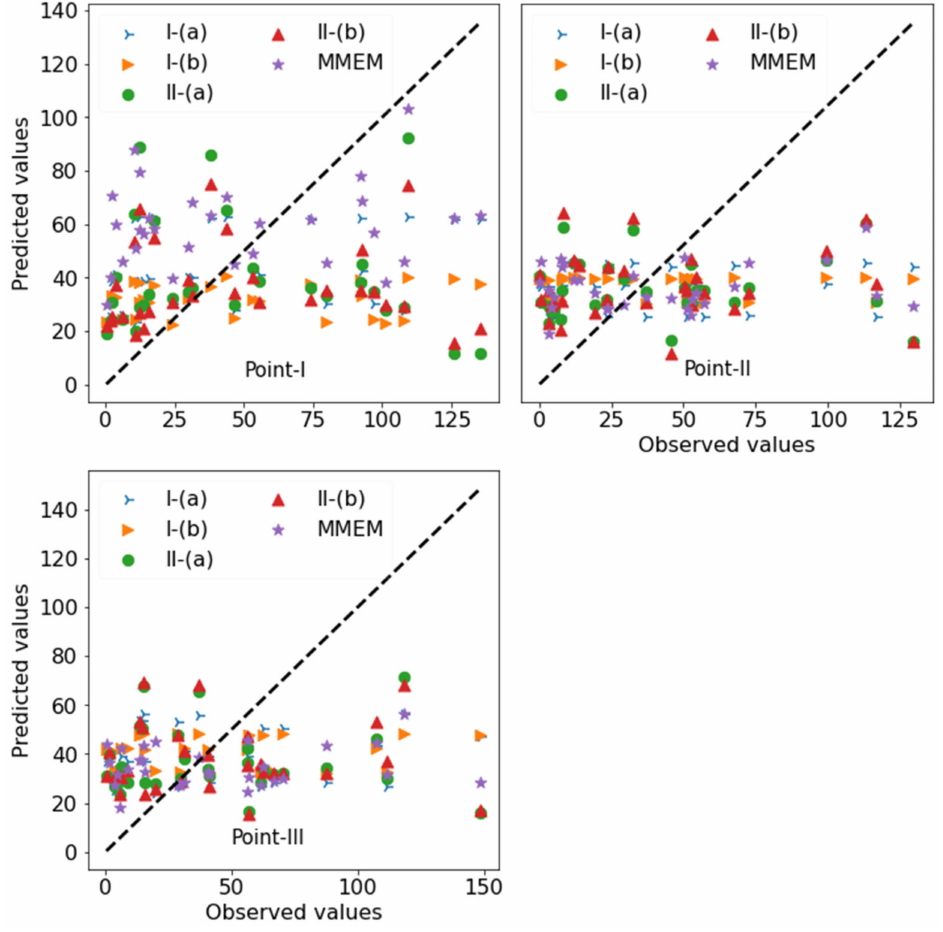
Figure 3. Comparison of the resemblance of dry and wet events produced by FBP and